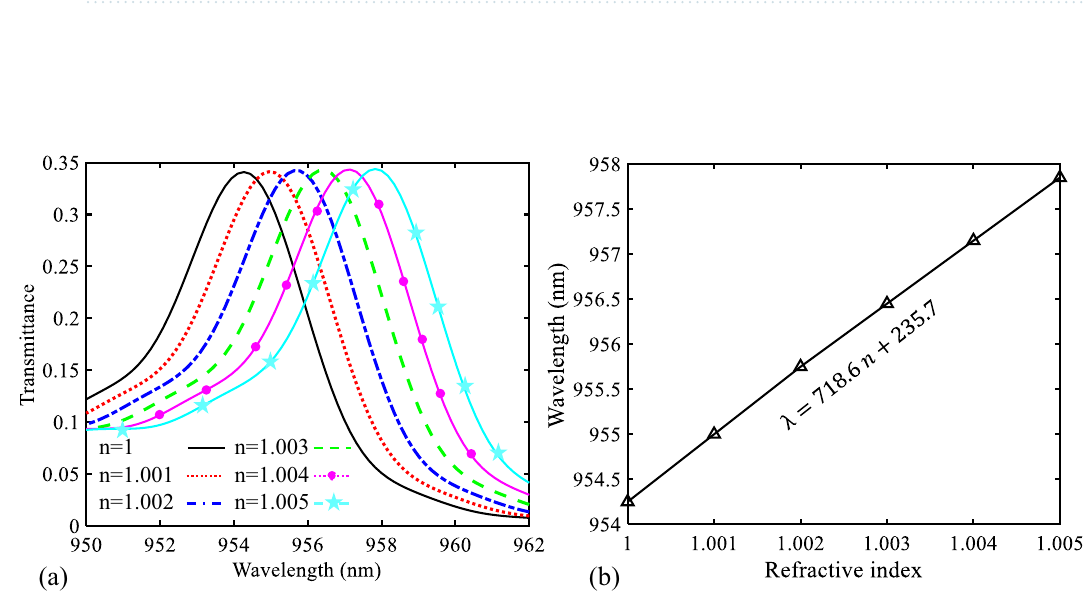
Figure 8. ( a ) Transmission spectra of the proposed biosensor I for refractive index changes from 1 to 1.005 in steps of 0.001. ( b ) Relationship between the wavelength of the PBG’s low edge and different values of the refractive